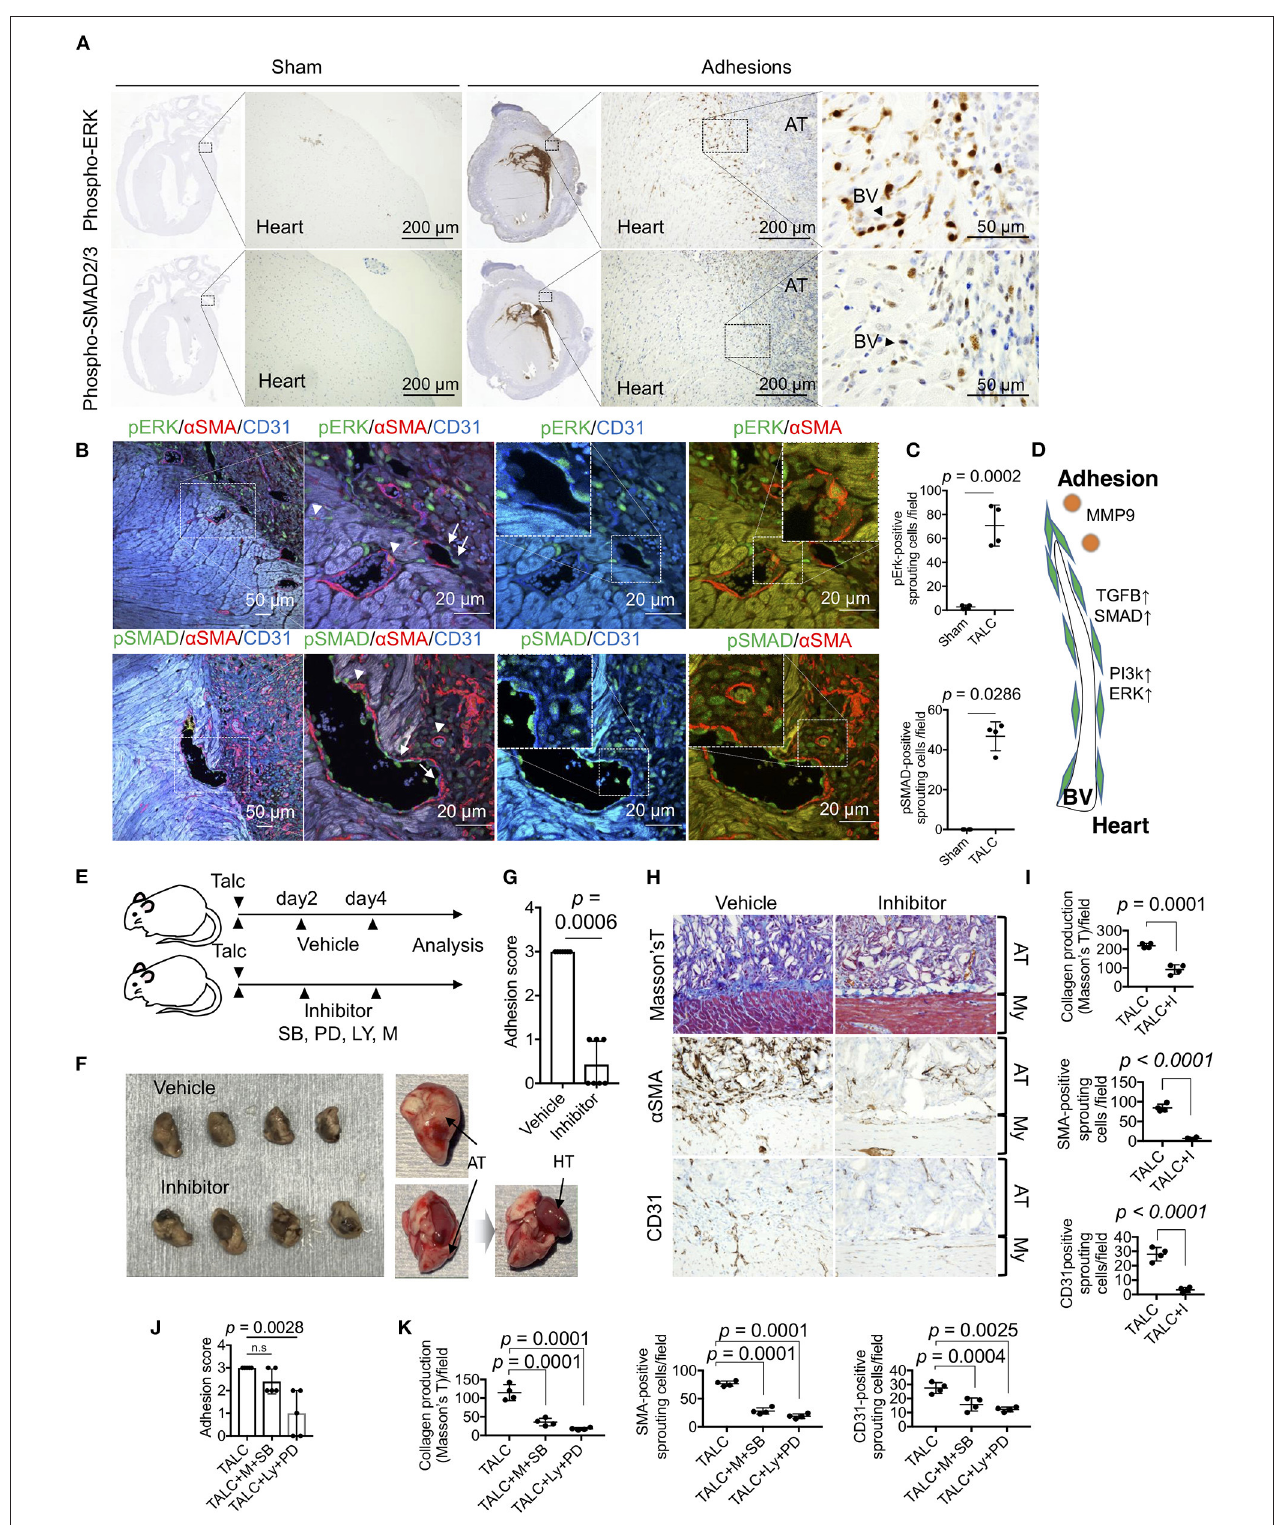
FIGURE 7 | Sprouting vessel-specific cell signaling is required for adhesion formation. (A) Immunohistochemical (IHC) staining for phospho-ERK (pERK) and phosoho-SMAD2/3 (pSMAD) in the whole heart tissues from the sham group and talc injection group. (Scale bar = 200 µ m). The areas surrounded by broken lines indicate magnified images. (Scale bar = 50 µ m). AT, adhesion tissue; BV, blood vessel. (B) Tissue localization of pERK and pSMAD-positive endothelial cells and